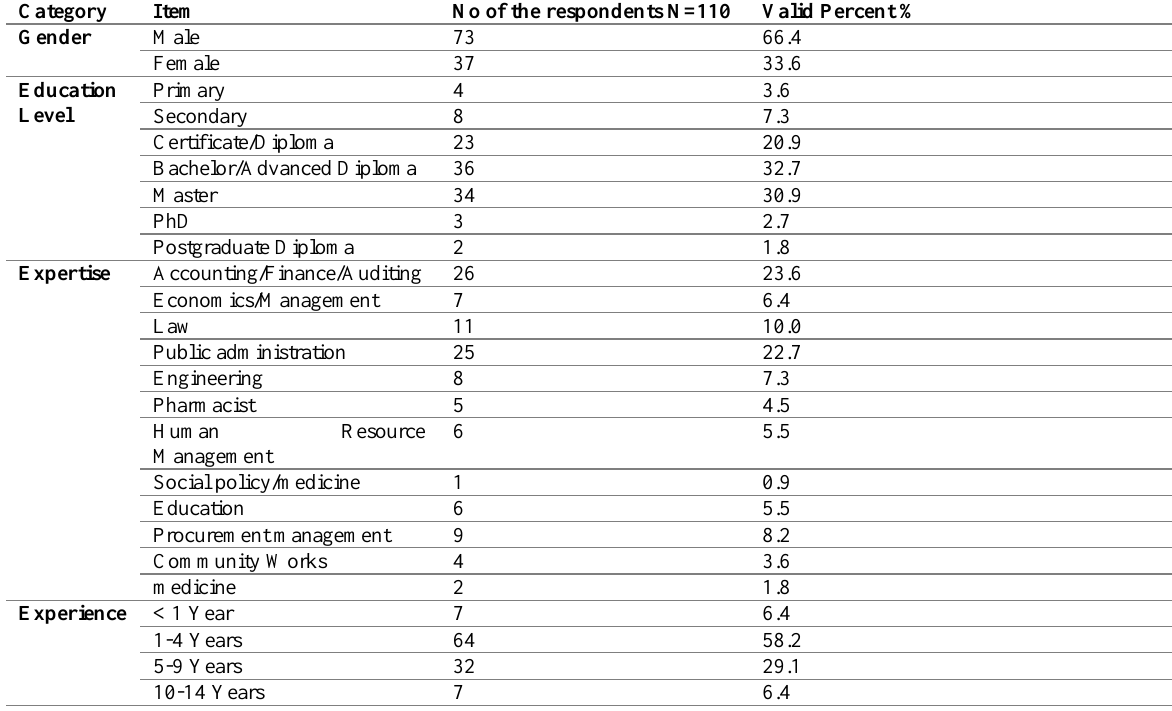
Table 2: Demographic Characteristics of the